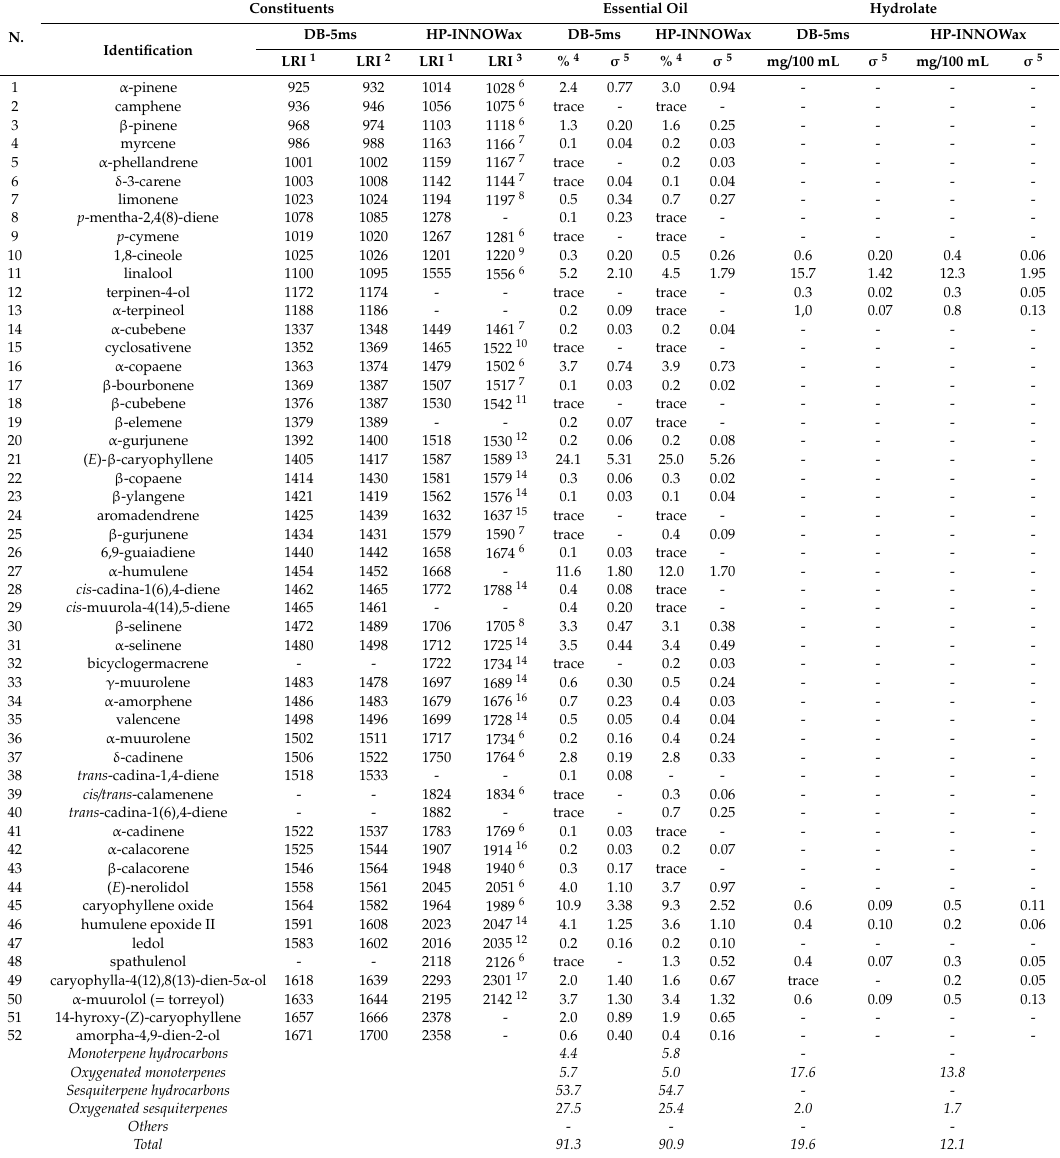
Table 1. Chemical analysis of Piper coruscans essential